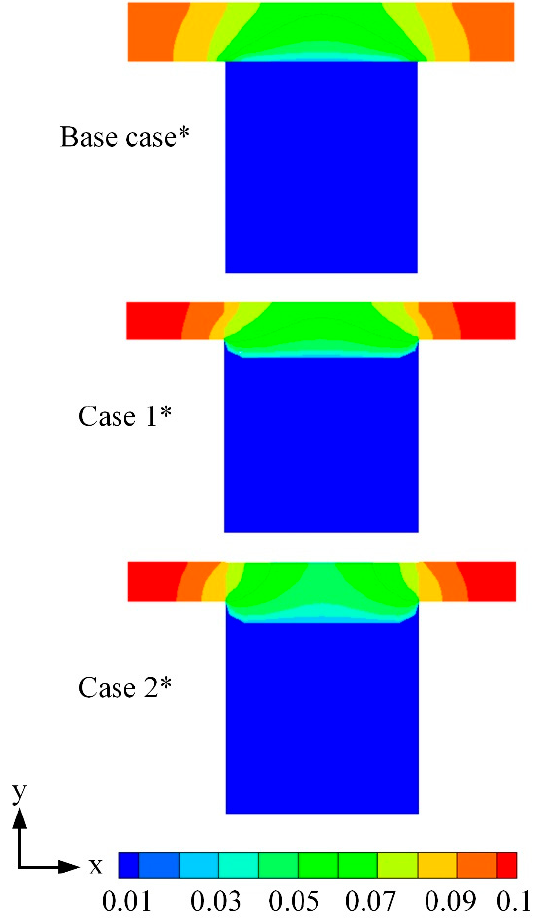
Figure 8. Distribution of liquid water volume fraction in the cathode channel cross-sectional plane near when the operating voltage is 0.6 V in the Base case*, Case 1* and Case 2*.